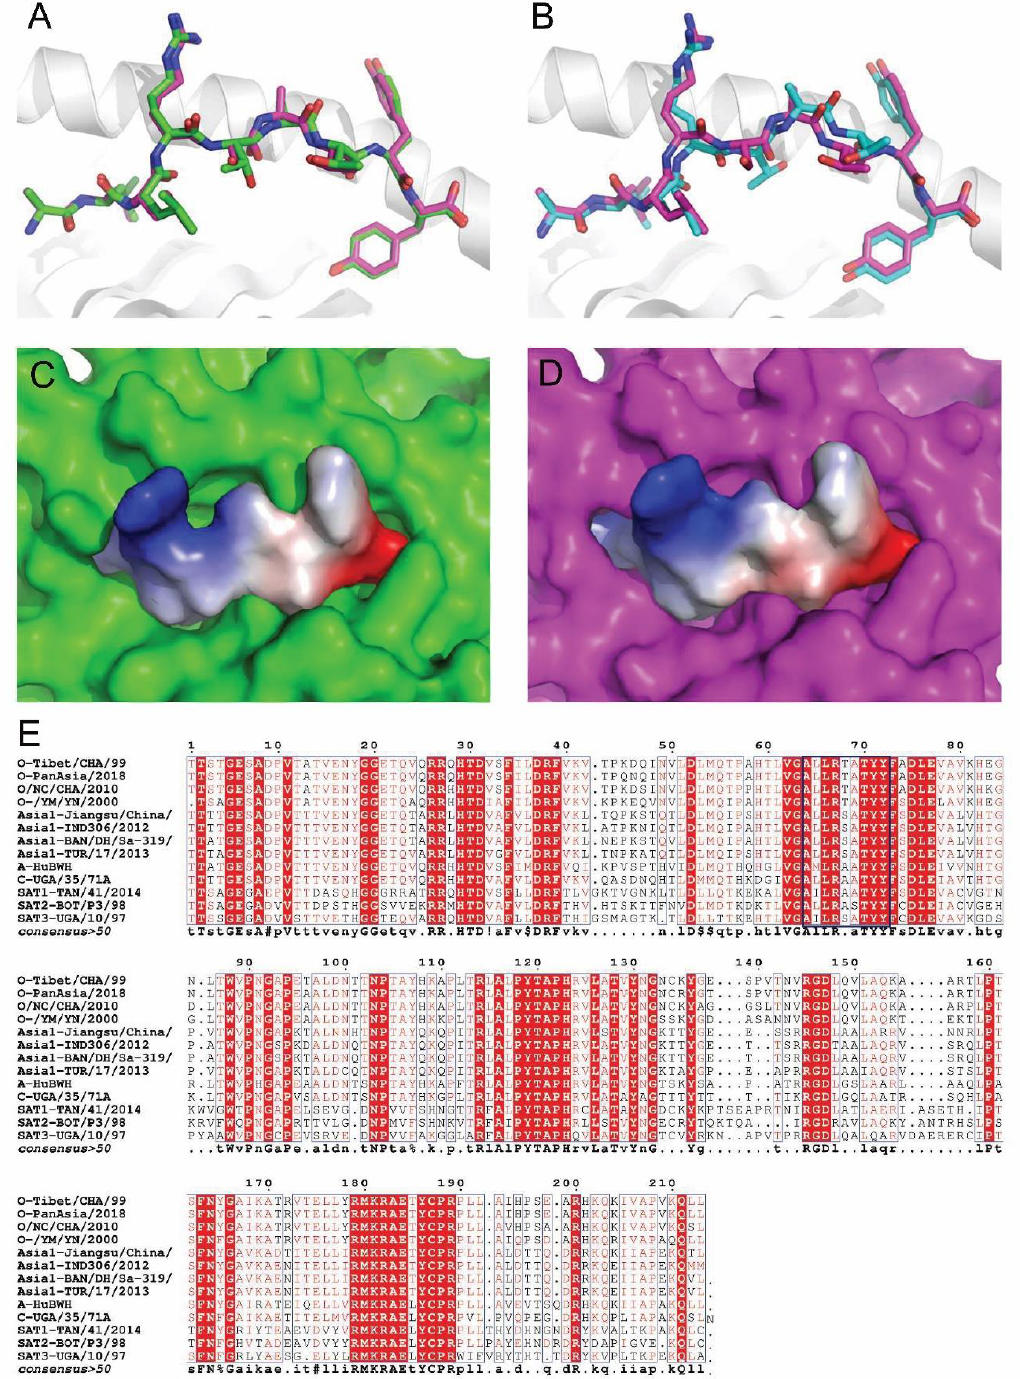
Figure 6. Analysis of the parallel presentation of peptides Hu64 and As64 by SLA-2*HB01, and the peptide conservation. ( A ) The superposition of As64 onto the Hu64 molecule 1 in the asymmetric unit of SLA-2*HB01; ( B ) the superposition of As64 onto the Hu64 molecule 2 in the asymmetric unit of SLA-2*HB01; ( C ) the vacuum electrostatic surface potential of Hu64 molecule 1 in the asymmetric unit; ( D ) the vacuum electrostatic surface potential of As64 exposed out of the peptide binding groove of SLA-2*HB01; ( E ) alignment of VP1 proteins derived from different serotypes of FMDV. The amino acids inside the dark blue quadrant indicate the sequence of peptides Hu64, As64, and Ahu64, which were derived from the O, Asia 1 and A, contrast to those from C, SAT1, SAT2, and SAT3 serotypes of FMDV.